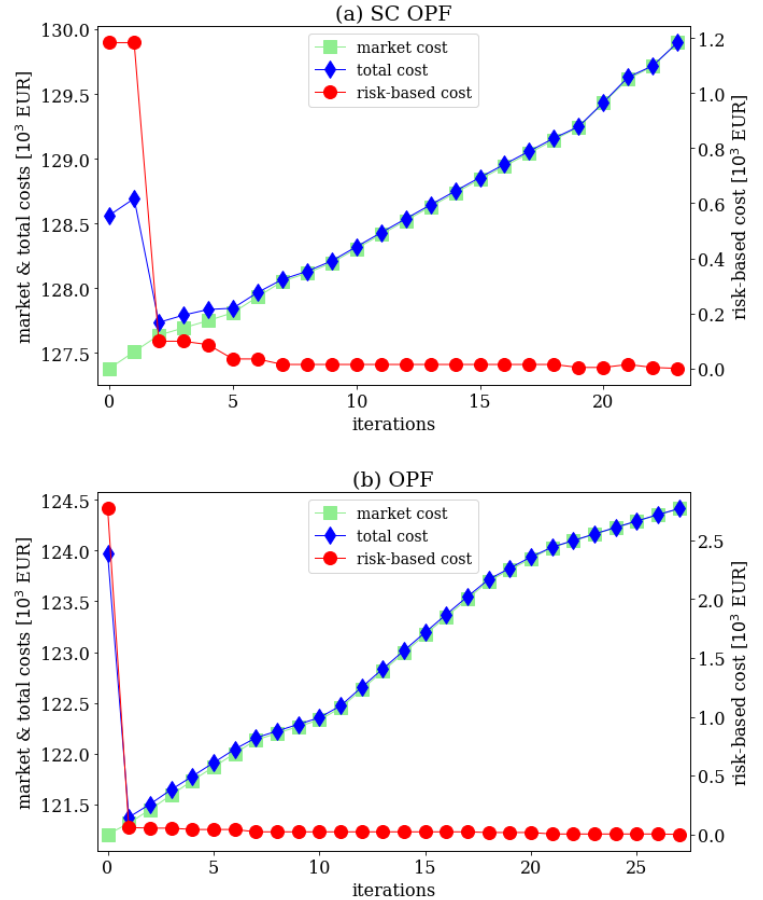
Figure 5. The costs obtained in the risk optimization process for the SC OPF ( a ) and the OPF ( b ) scenarios: the market cost (green), the risk-based cost (red—plotted with respect to the right vertical axis) and the total cost—the sum of two former ones (blue) with minimal value after 2 iterations in ( a ) and 1 iteration in ( b